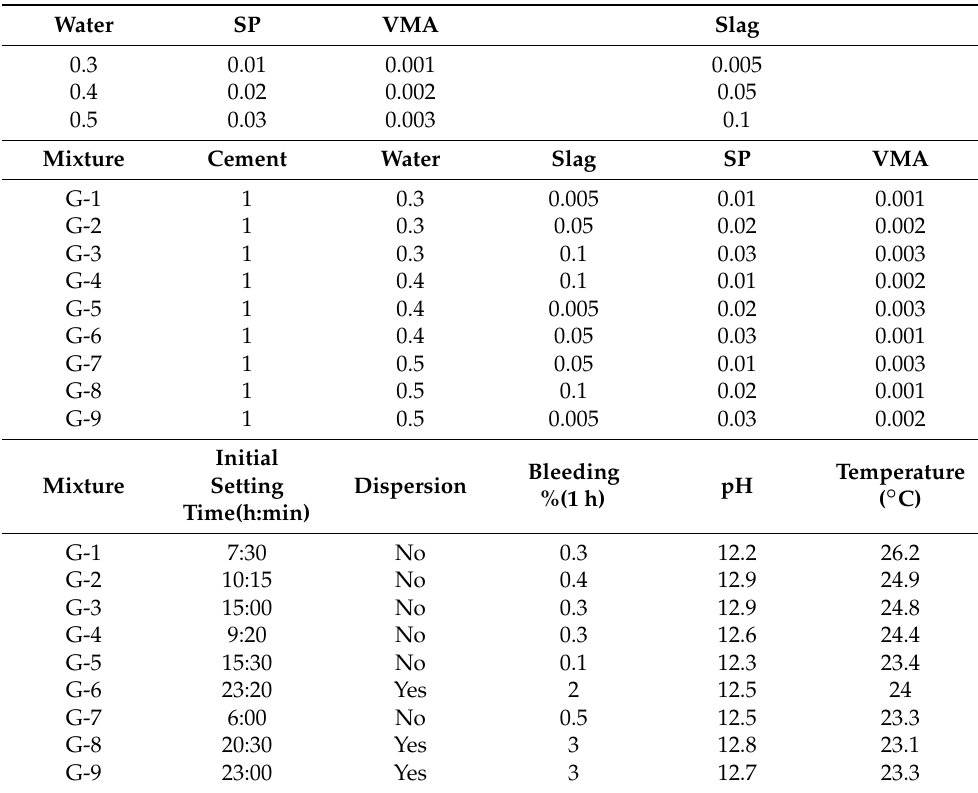
Table 6. Ratios of various constituents based on the Taguchi